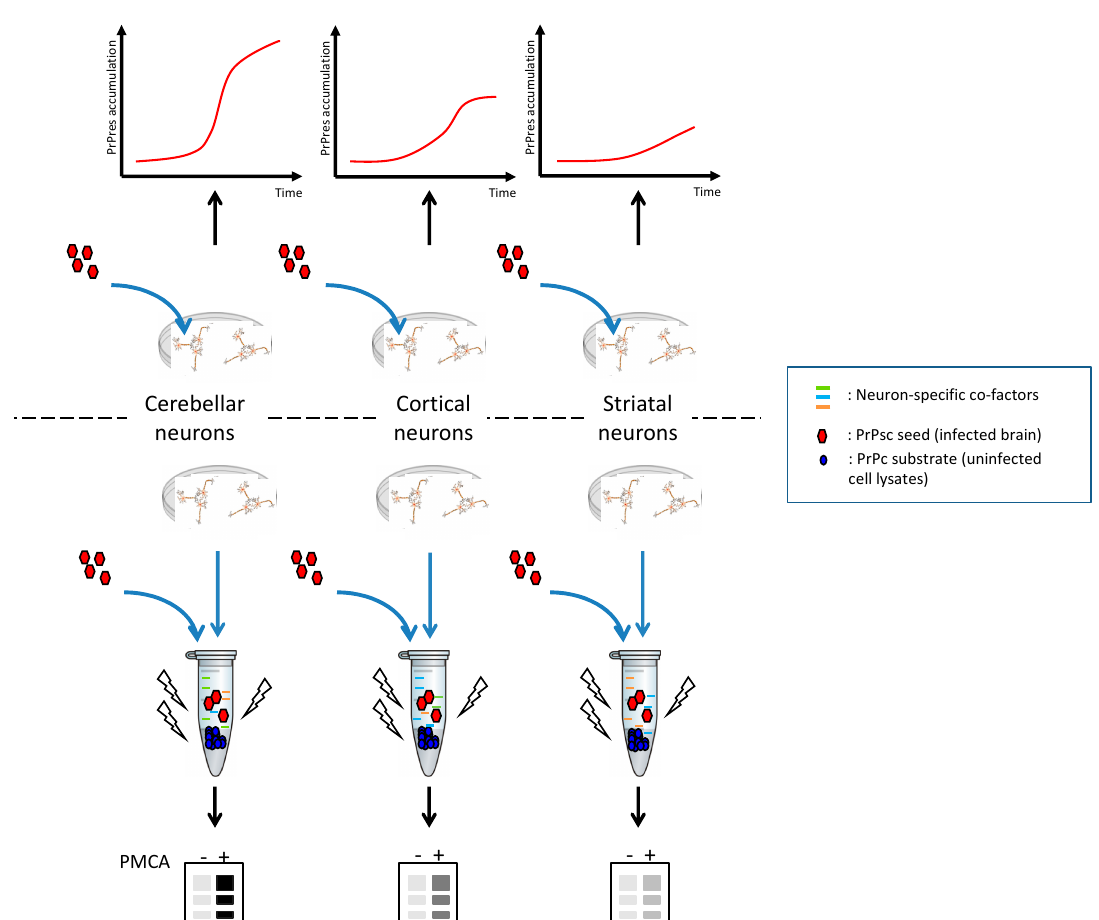
Scheme 3. Schematic representation of cellular neuron-specific tropism and general principle of neuron-specific PMCA (nsPMCA). Infection kinetics are compared with amplification levels. Manipulation of neuronal cultures (change of protein expression, post-translational